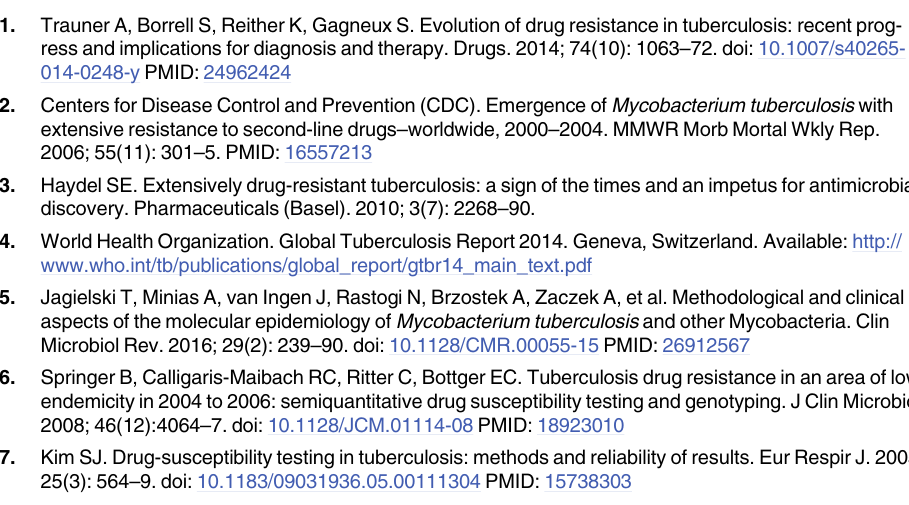
S1 Table. Pairwise correlation coefficients of MIC distributions. S2 Table. Correlation of MICs for selected drug pairs. S3 Table. Phenotypic characterization of strains with particular